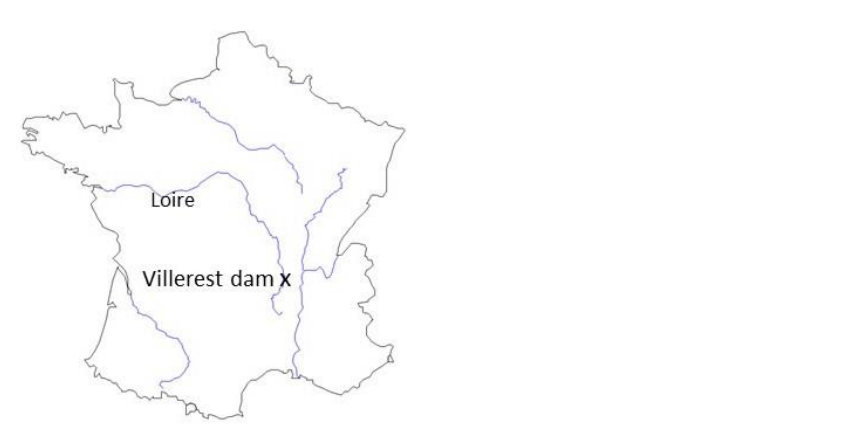
Figure 1. Map of France, locating the Loire River and the Villerest dam.